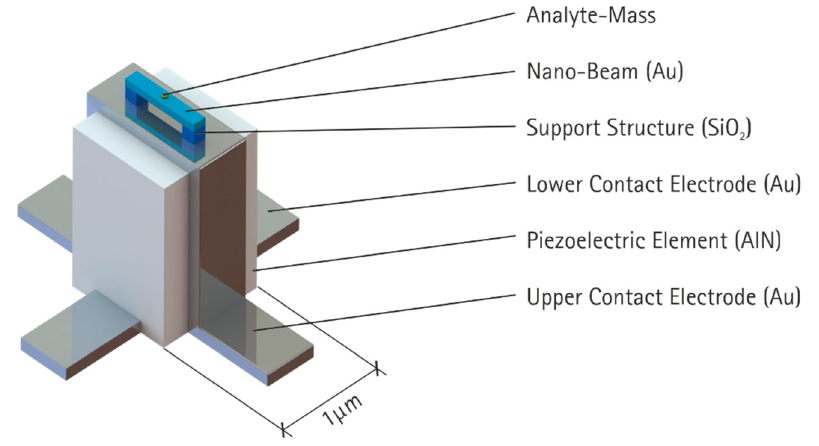
Figure 1. Novel setup for a piezoelectric co-resonant mass-detector. The piezoelectric element was designed as a longitudinal resonator, and the nano-beam was operated in a bending mode.